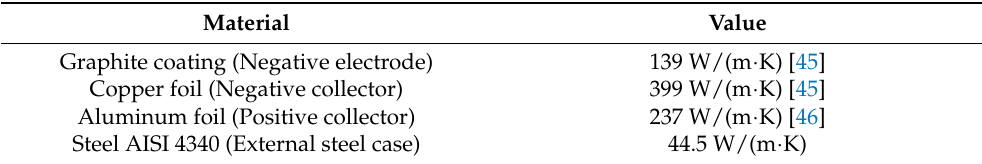
Table 5. Thermal conductivity of some materials for lithium-ion batteries. Material Value Graphite coating (Negative